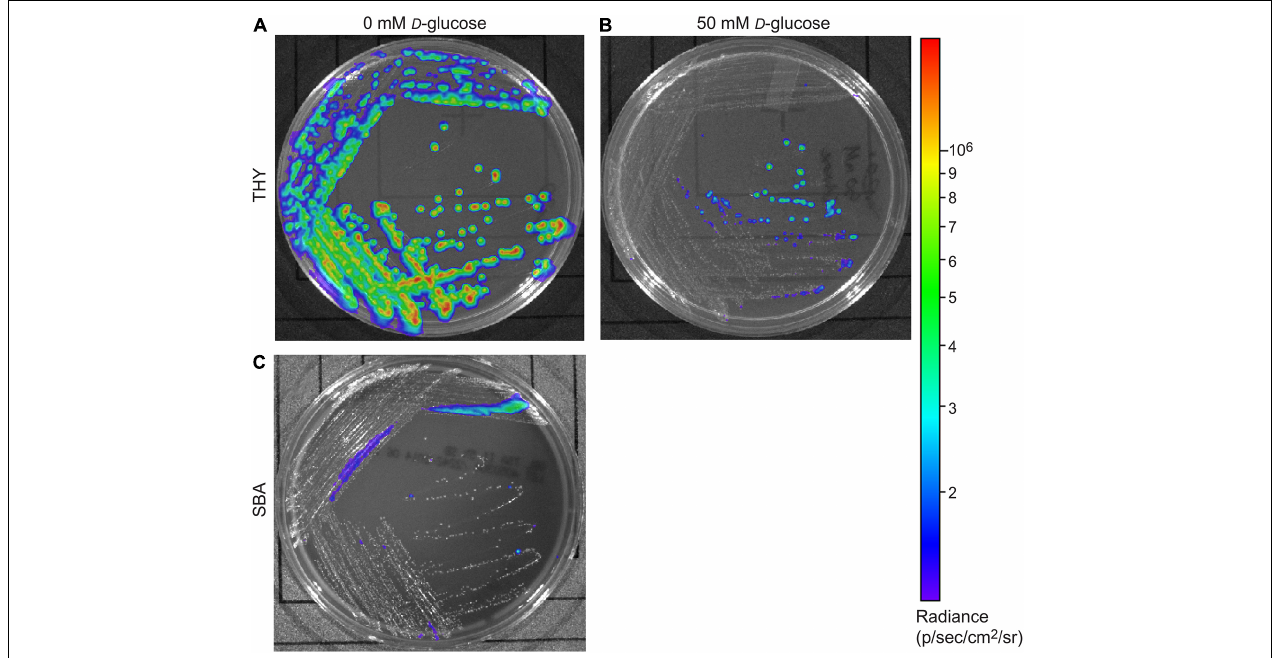
FIGURE 1 | Glucose effect on bioluminescent production of S. pyogenes Xen20. Strep. Xen20 was plated on Todd-Hewitt with yeast extract (THY) without (A) or with the addition of excess D-glucose (B) or on sheep blood agar (SBA) and incubated for 20 h at 37 ◦ C (C)